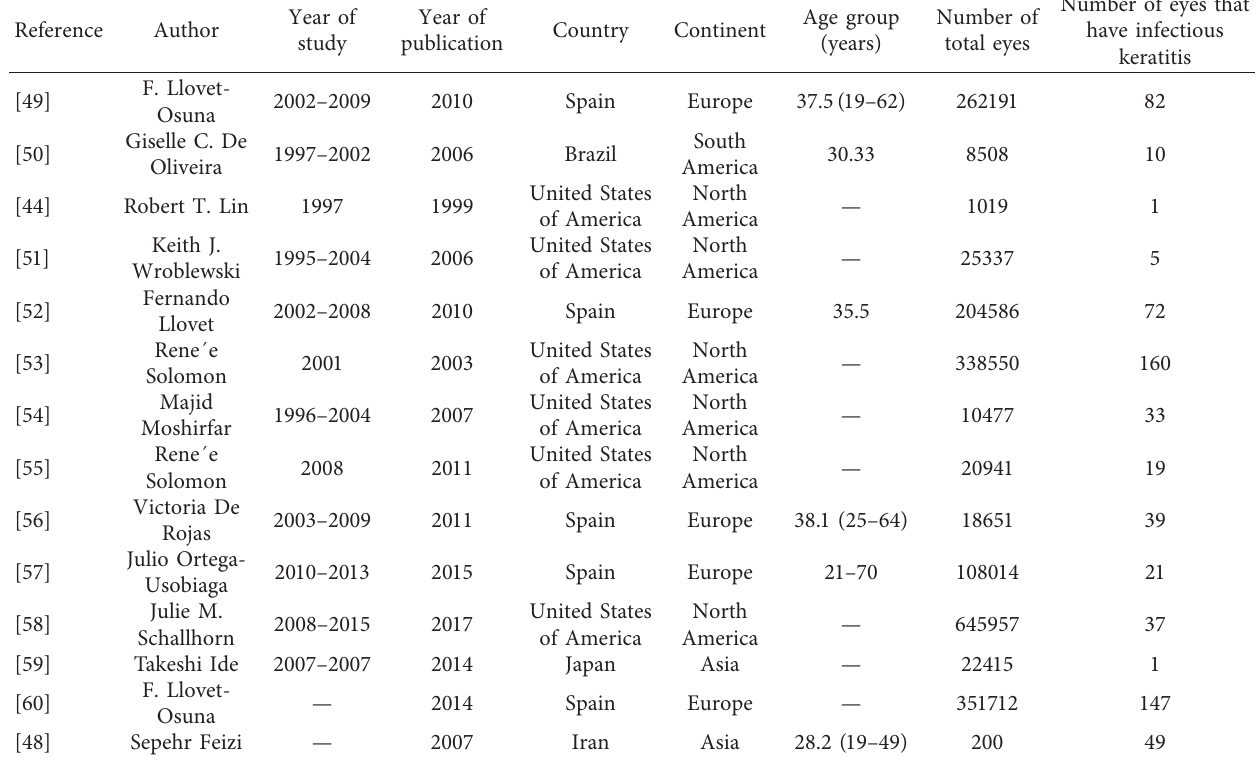
Table 1: Extracted data from articles that are included in the meta-analysis.